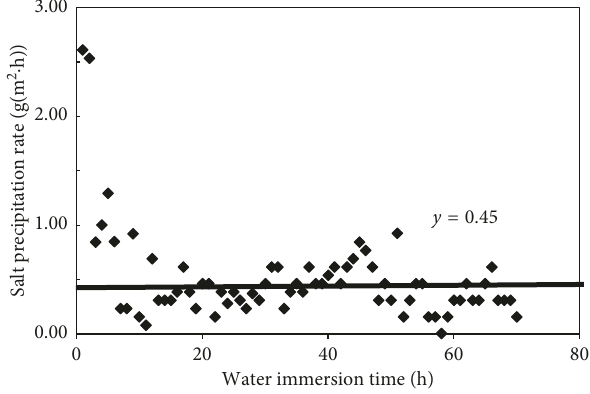
Figure 12: Salt precipitation rate versus